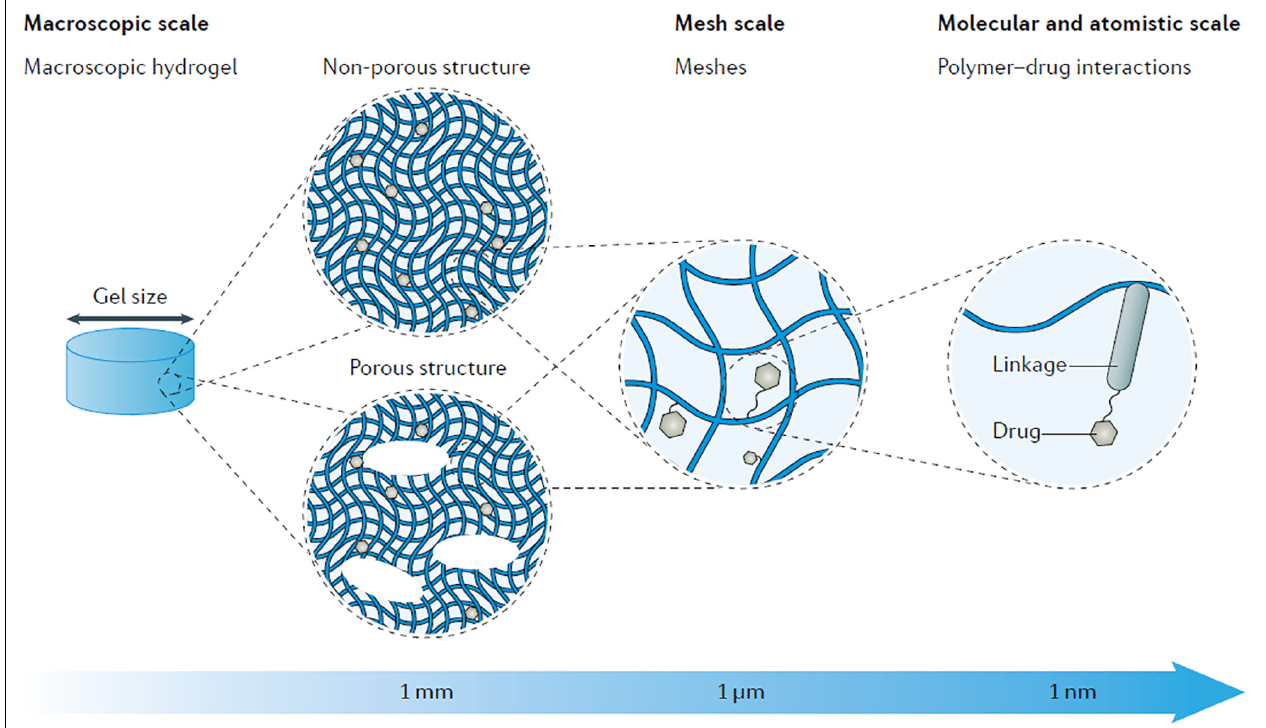
FIGURE 2 | Schematic showing the multi-scale tunability of hydrogels for drug delivery applications, showcasing the versatility of drug delivery properties based on material characteristics. By modulating material properties such as composition, porosity, and intramolecular bonding the degradation and drug release kinetics can be tuned as well as other properties such as gelation temperature and shear thinning mechanics. Reprinted by permission from Springer Nature: Nature Reviews Materials, Designing hydrogels for controlled drug delivery, Jianyu Li, David J. Mooney, Copyright